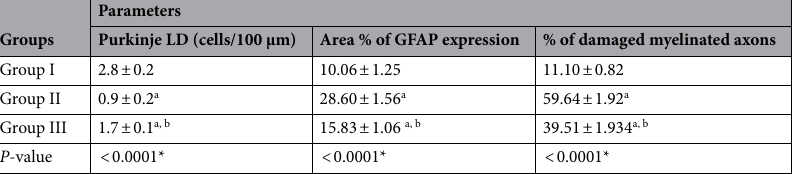
Table 2. Comparison of the Purkinje cell linear density (Purkinje LD), the area percent (%) of GFAP expression, and the percent (%) of damaged myelinated axons in all studied groups. Data are represented as Mean ± SD. *means statistically significant difference. a Statistically significant as compared with the group I, P < 0.05. b Statistically significant as compared with the group II, P <